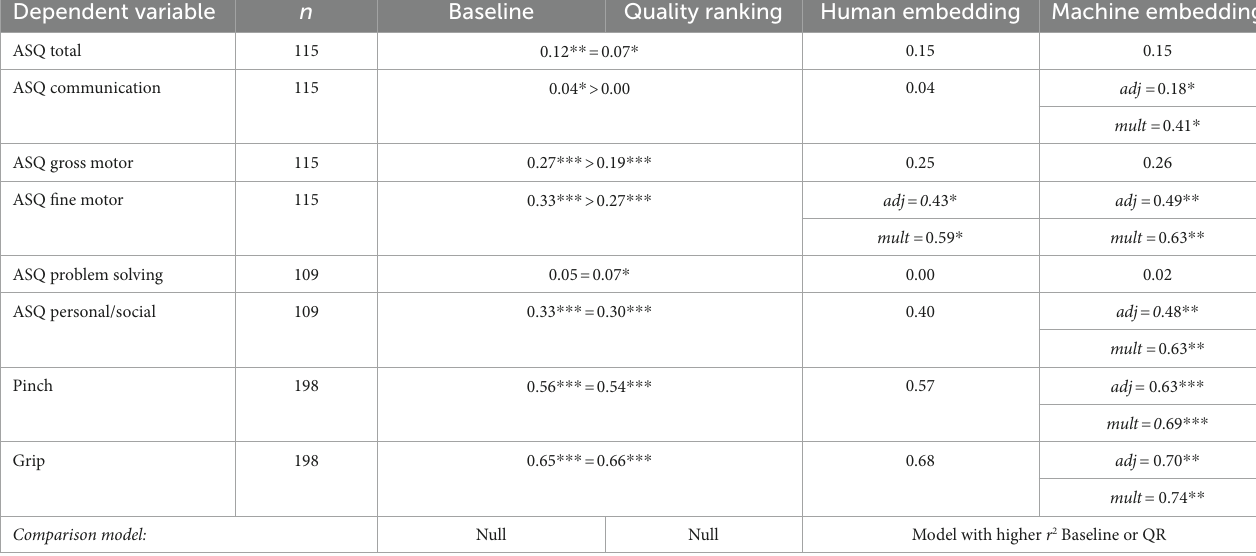
accounts for reliably more/less variance than another. Asterisks indicate significance levels at * p < 0.05, ** p < 0.01, *** p < 0.001. TABLE 4 Model fits predicting cognitive/behavioral and motor characteristics of